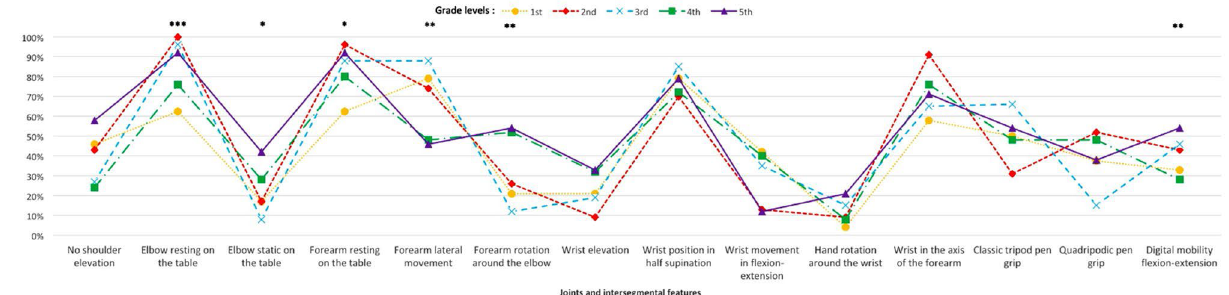
Figure 1. Postural and gestural features of right-handed children drawing a line of cycloid loops. For each grade, frequency of joints and inter-segmental participations of the arm.